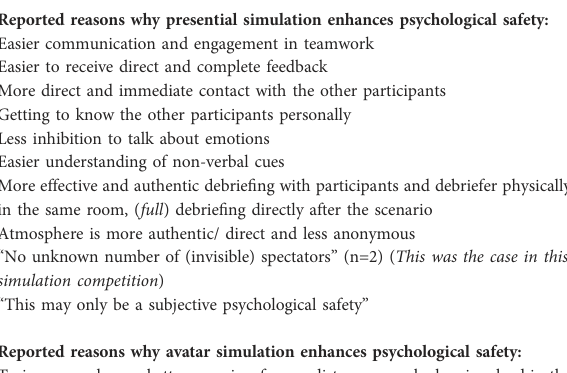
TABLE 5 Reported reasons why different types of simulation offer psychological safety in different ways and reported learning experiences from distance